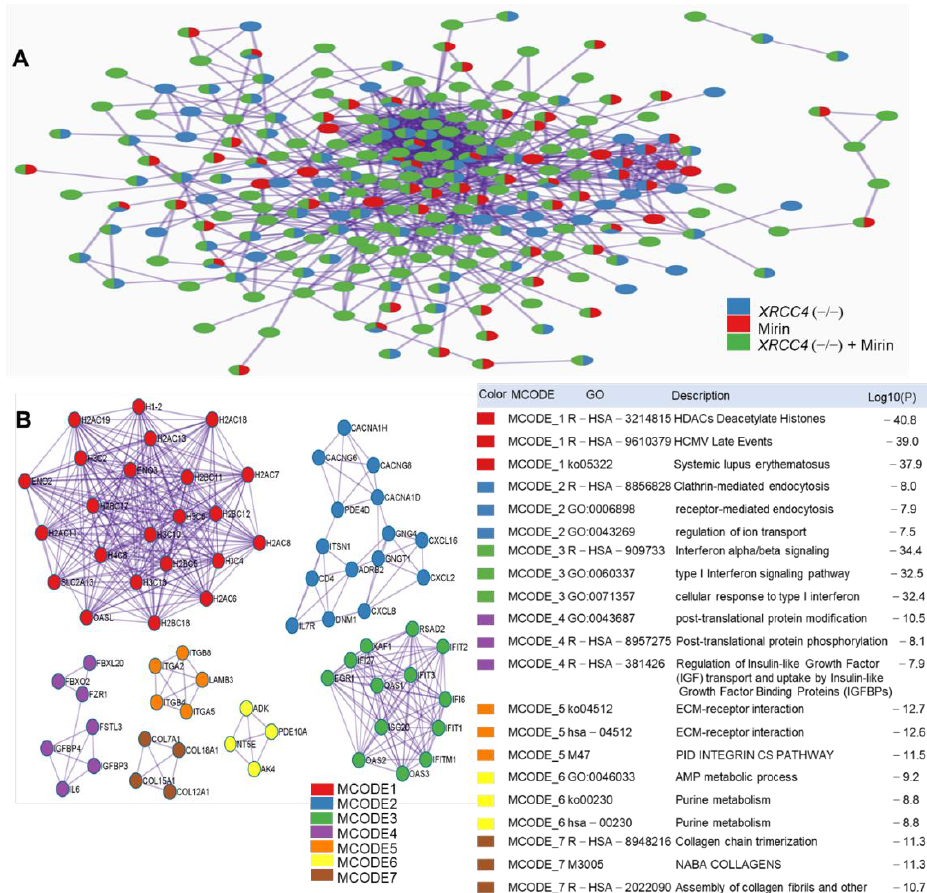
Figure 7. Protein–protein interaction network analysis. ( A ) PPI network of DEGs for each treatment group. Nodes are displayed as pies to indicate sample. ( B ) MCODE components were identified from the merged network for all samples. Each MCODE network is assigned a unique color and the network was generated with Cytoscape (v3.1.2). The MCODE GO term, description, and p values are shown. The analyses are based on duplicate experiments.